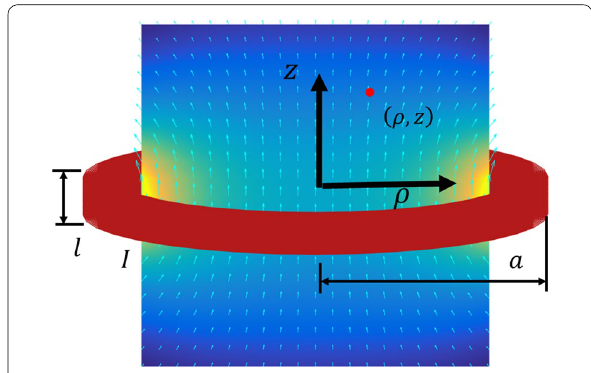
Figure 1 Finite long current-carrying loop-shaped coil